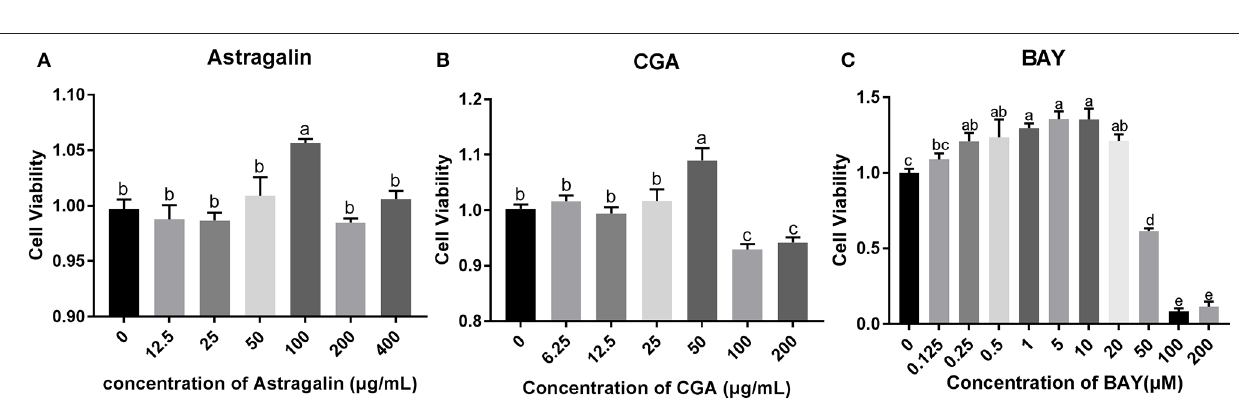
Frontiers in Veterinary Science | www.frontiersin.org